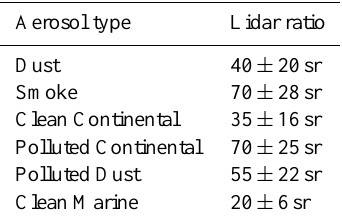
Table 1. CALIPSO aerosol types and their associated 532nm lidar ratio